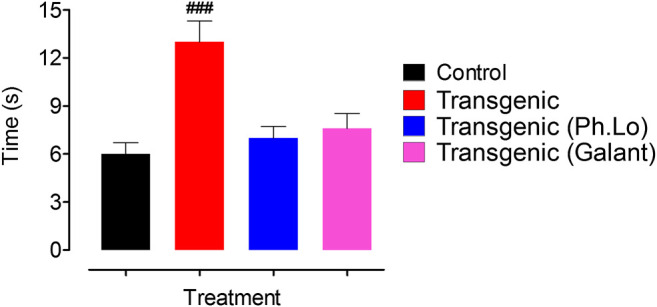
Effect of Ph. Lo on motor skills and coordination in animals groups.